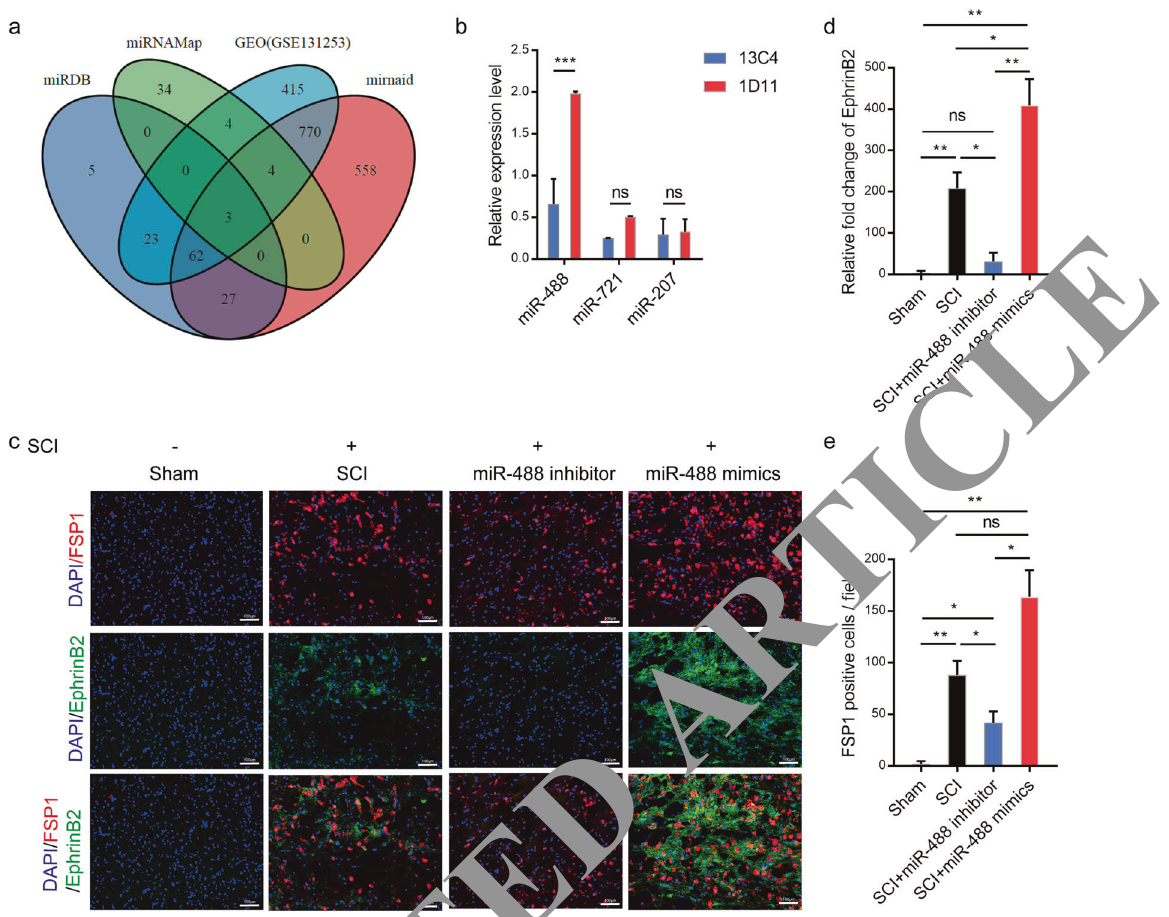
Fig. 6 MiR-488 regulates FSP1 + fi broblasts distribution and EphrinB2 expression in the lesion site. a Prediction of targeted miRNAs in fi broblasts capable of regulating EphrinB2 after SCI via miRDB, miRNAMap, GEO(GSE131253) and mirnaid. b Relative expression level of the three miRNAs that were screened out are validated in 13C4 control group and 1D11 group mice at 2 weeks after SCI by qPCR. c Representative images of immuno fl uorescent analysis of FSP1 (red), EphrinB2 (green) and DAPI (blue) in each group at 2 weeks after SCI. Scale bars = 100 μ